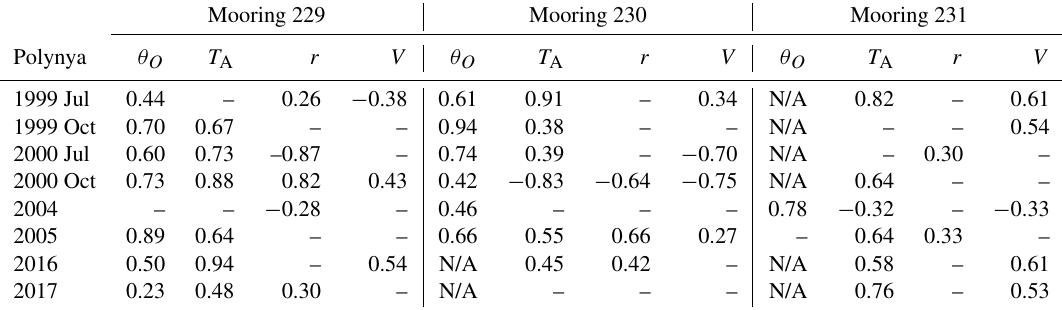
Table 1. For the polynya events since the first mooring deployment in 1996, correlation between the brightness temperature T4 and the ocean temperature from the mooring’s shallowest sensor θ O , the 2m air temperature T A , the 1000hPa relative humidity r , and the 10m wind speed V from ERA5 (see Methods), at the location of the three moorings (229 to 231), over the 15d before the polynya opens. For the mooring temperature, a lag of up to 10d is permitted in order to account for the upwelling velocity. N/A indicates the absence of a sensor shallower than 300m. Only significant correlations (at 95%) are